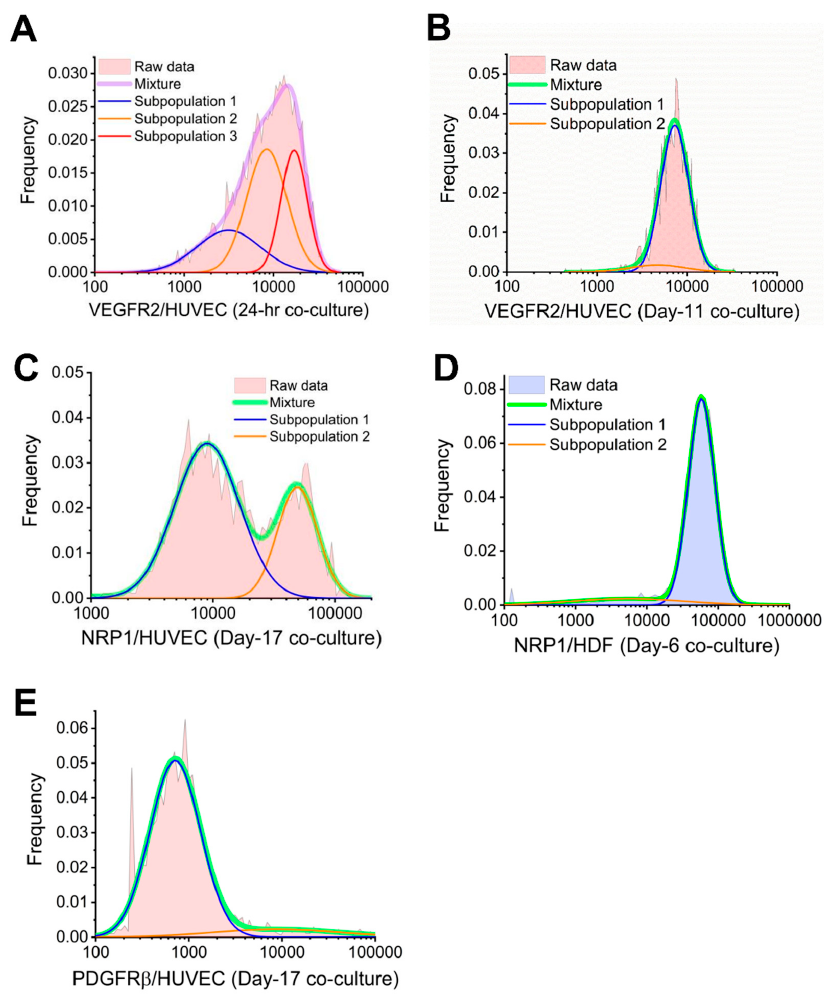
Figure 5. Bayesian information criterion (BIC)-assisted Gaussian mixture modeling identifies subpopulations within mixtures. ( A ) The 24-h cocultured HUVECs have three subpopulations expressing 3100 VEGFR2 per cell, 8400 VEGFR2 per cell, and 17,000 VEGFR2 per cell on their plasma membranes. ( B ) Day-11 cocultured HUVECs have two subpopulations expressing 4700 plasma membrane VEGFR2 per cell and 7300 plasma membrane VEGFR2 per cell. ( C ) Day-17 cocultured HUVECs have two subpopulations expressing 9,000 plasma membrane NRP1 per cell and 49,300 plasma membrane NRP1 per cell. ( D ) Day-6 cocultured HDFs have two subpopulations expressing 5500 plasma membrane NRP1 per cell and 58,500 plasma membrane NRP1 per cell. ( E ) Day-17 cocultured HUVECs have two subpopulations expressing 700 and 8800 plasma membrane PDGFR β per